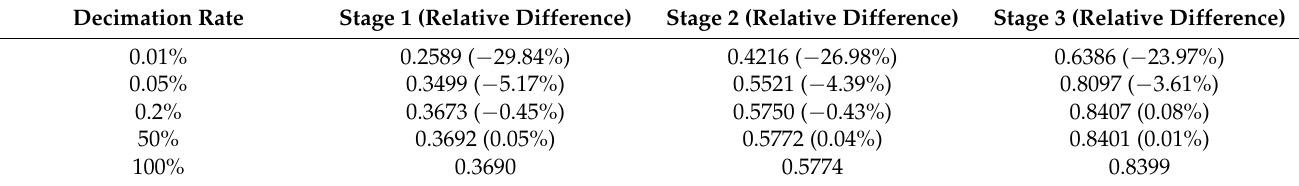
Table 4. LAI (leaf area index) and relative difference of the various configurations for all growth stages.